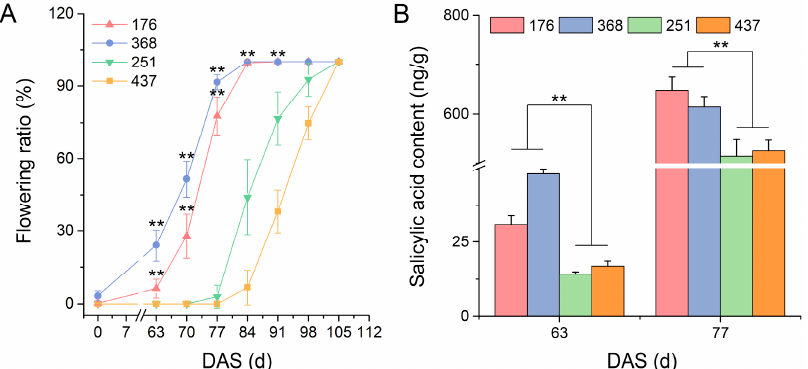
10 of 19 Figure 8. Biosynthesis and signal transduction of salicylic acid ( A ) and gibberellin ( B ) in V. sativa . Heatmap of transcript levels for genes and contents of the metabolites involved in the biosynthesis and signal transduction of salicylic acid and gibberellin. 2.10. Variation of Salicylic Acid Content in Various V. sativa Accessions As shown in Figure 9A, the V. sativa accessions 176 and 368 began to blossom 63 DAS, and their full-bloom stage appeared 84 DAS, while 251 and 437 began to blossom 77–84 DAS. In conclusion, the bloom stages of 251 and 437 were two weeks later than those of 176 and 368. In order to further verify the variation in the salicylic acid content in early- and late-flowering V. sativa accessions (Figure S8), the shoot samples (shoot tip length =